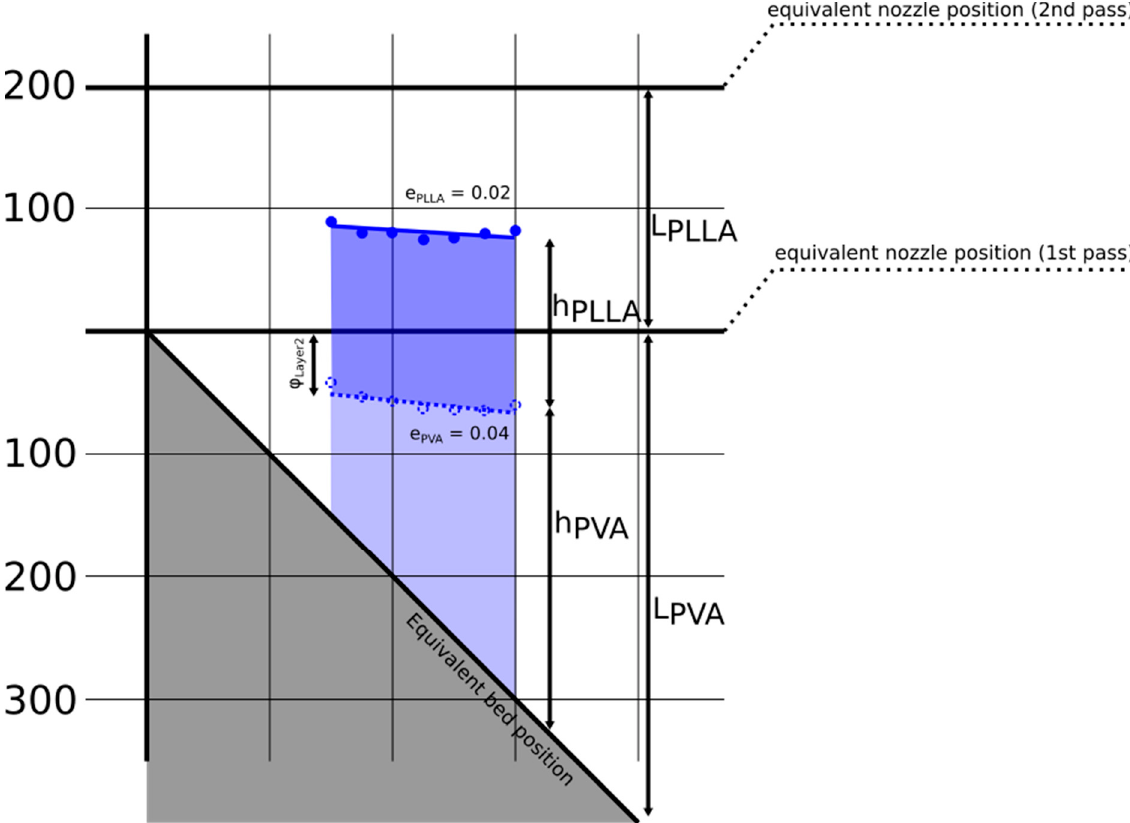
Figure 11. A representation of the PVA and PLLA layer thicknesses previously presented in Figure 8. Layers are visualised on a 45° sloped printing surface. PVA and PLLA layers are represented by dashed and solid markers, respectively. The surface slope is shown to be drastically reduced in severity, with the heavily shaded region showing uniform PLLA thickness, h PLLA .